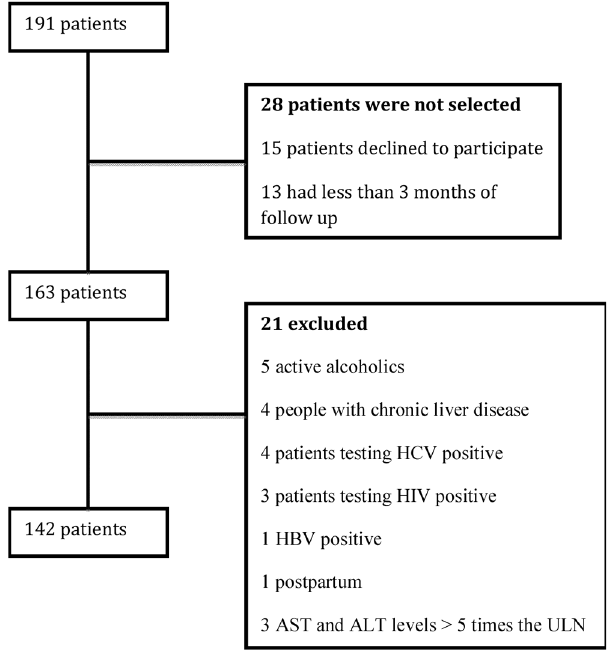
Figure 1 - A flow chart of the patients who met the inclusion/ exclusion criteria for the study. ULN, AST and ALT. Table 1 - The major medications used among the 142 patients with predialysis CKD. Major Medications in